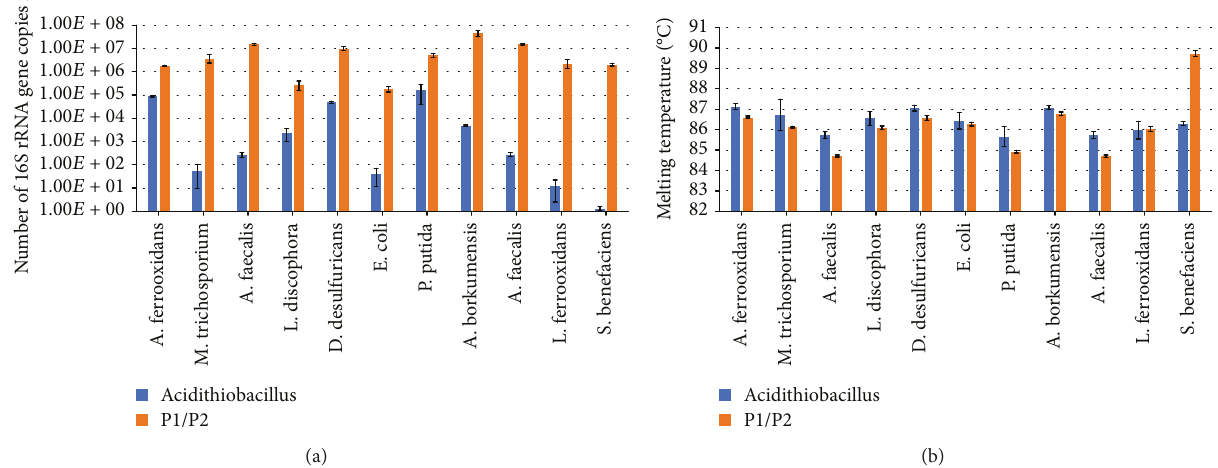
Figure 2: (a) The ampli fi cation of 16S rRNA genes with Acidithiobacillus targeting (blue) and general bacteria targeting P1 and P2 (orange) primers using 0.5ng DNA per reaction and (b) the melting curve analysis of the ampli fi ed 16S rRNA gene fragments. All reactions were done in triplicate, and the error bars indicate standard deviation.